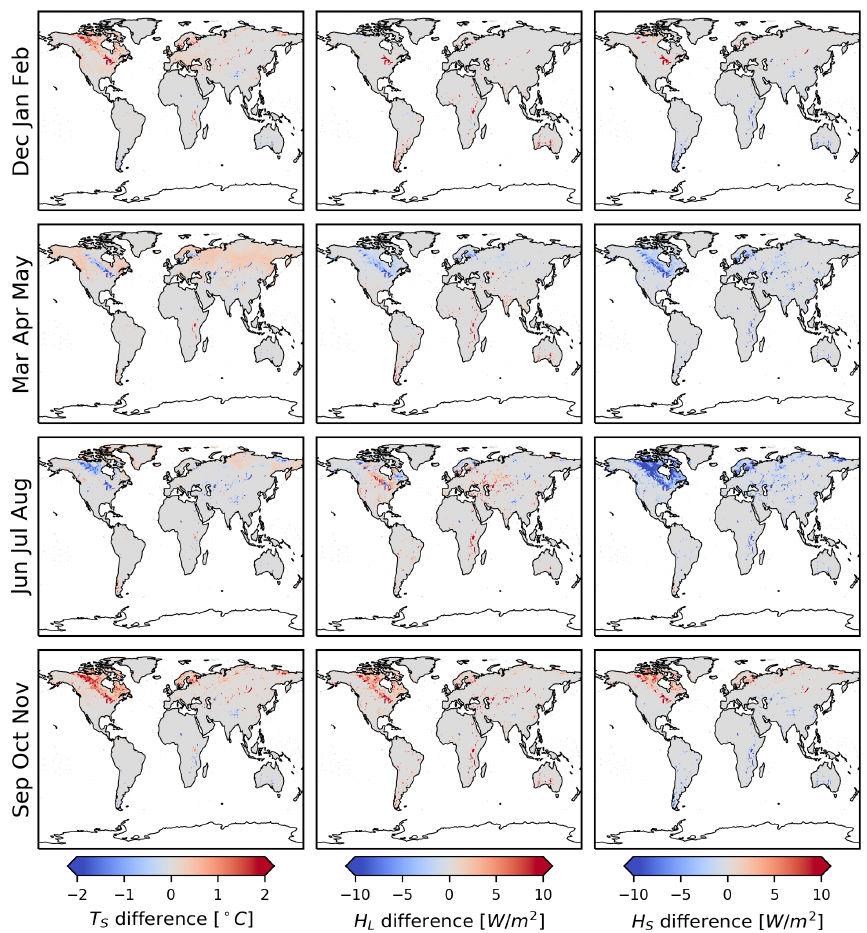
Figure 10. Differences (CJR3med − CJR0) in the surface temperature (first line) latent heat flux (second line) and sensible heat flux, simu- lated with and without lakes, averaged over 3-month periods starting from December (one per